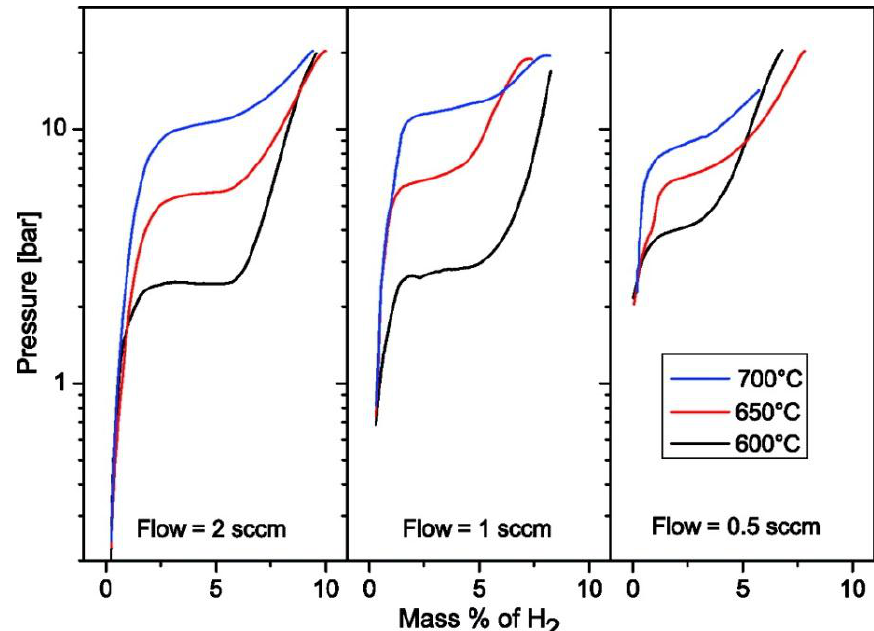
Figure 1. Pressure, composition, and temperature (PCT) isotherms measured on NaBH 4 at a constant hydrogen flow of 2, 1, and 0.5 cm 3 (STP) min −1 [7]. Reprinted with permission from [7], copyright 2010 The American Chemical